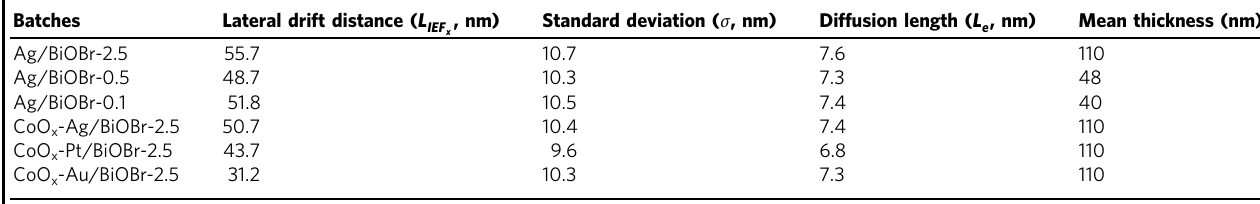
Source data are provided as a Source Data fi